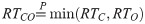
Diagram outlining the methods to test each of our race equalities, e.g., RTCO=Pmin(RTC,RTO).The details of various components, in boxes (1)-(8), are described in the text.